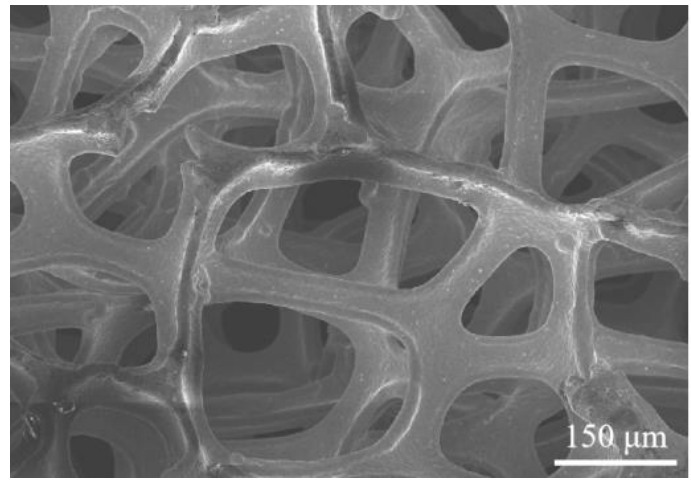
Figure 2. Microstructure of Cu foam.